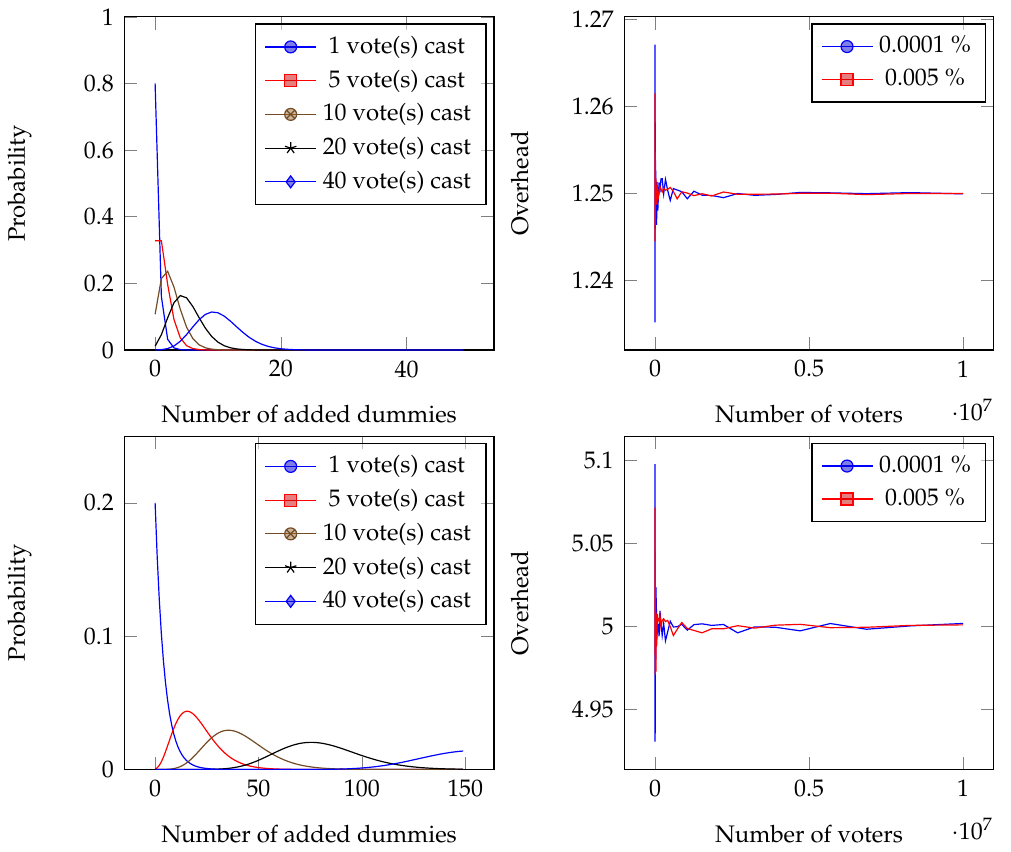
Figure 3. Negative binomial distribution ( left ) with probability of success 0.8 ( top ) and 0.2 ( bottom ). This distribution is used to select the number of dummies to add per voter, depending on how many votes a voter cast. Overhead caused by the dummy addition ( right ), having used the corresponding distributions ( top and bottom ), where the overhead is counted as (( # votes + # dummies ) /# votes )